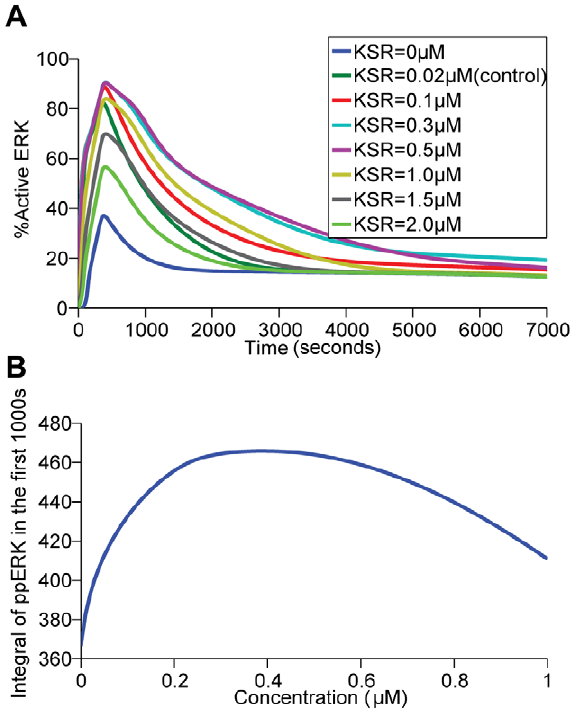
Figure 4. The biphasic effect of KSR on ERK activation. (A) Percentage of active ERK was plotted over the period indicated by varying the concentrations of KSR from 0 to 2 m M. (B) Existence of an optimal scaffold concentration of KSR (0.3–0.5 m M) by plotting the time integral of ppERK/ERK in the first 1000 seconds and KSR’s initial concentrations.